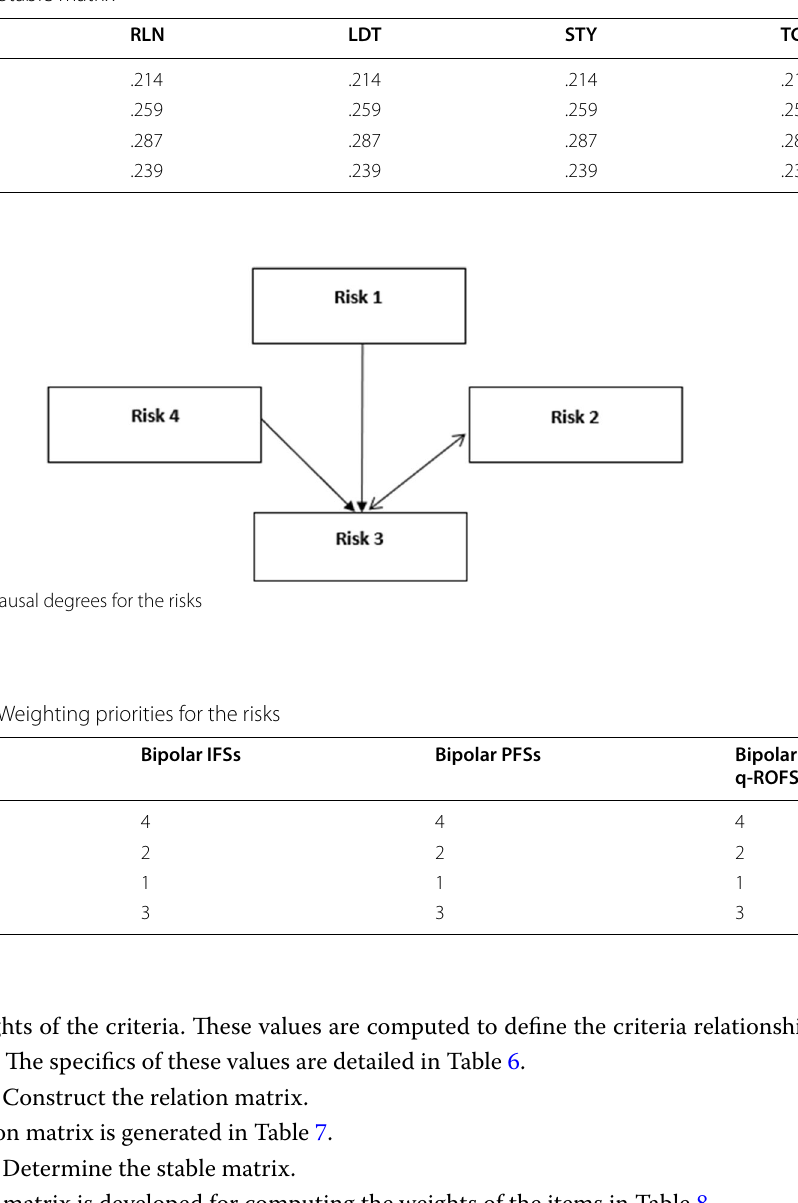
Table 8 Stable matrix